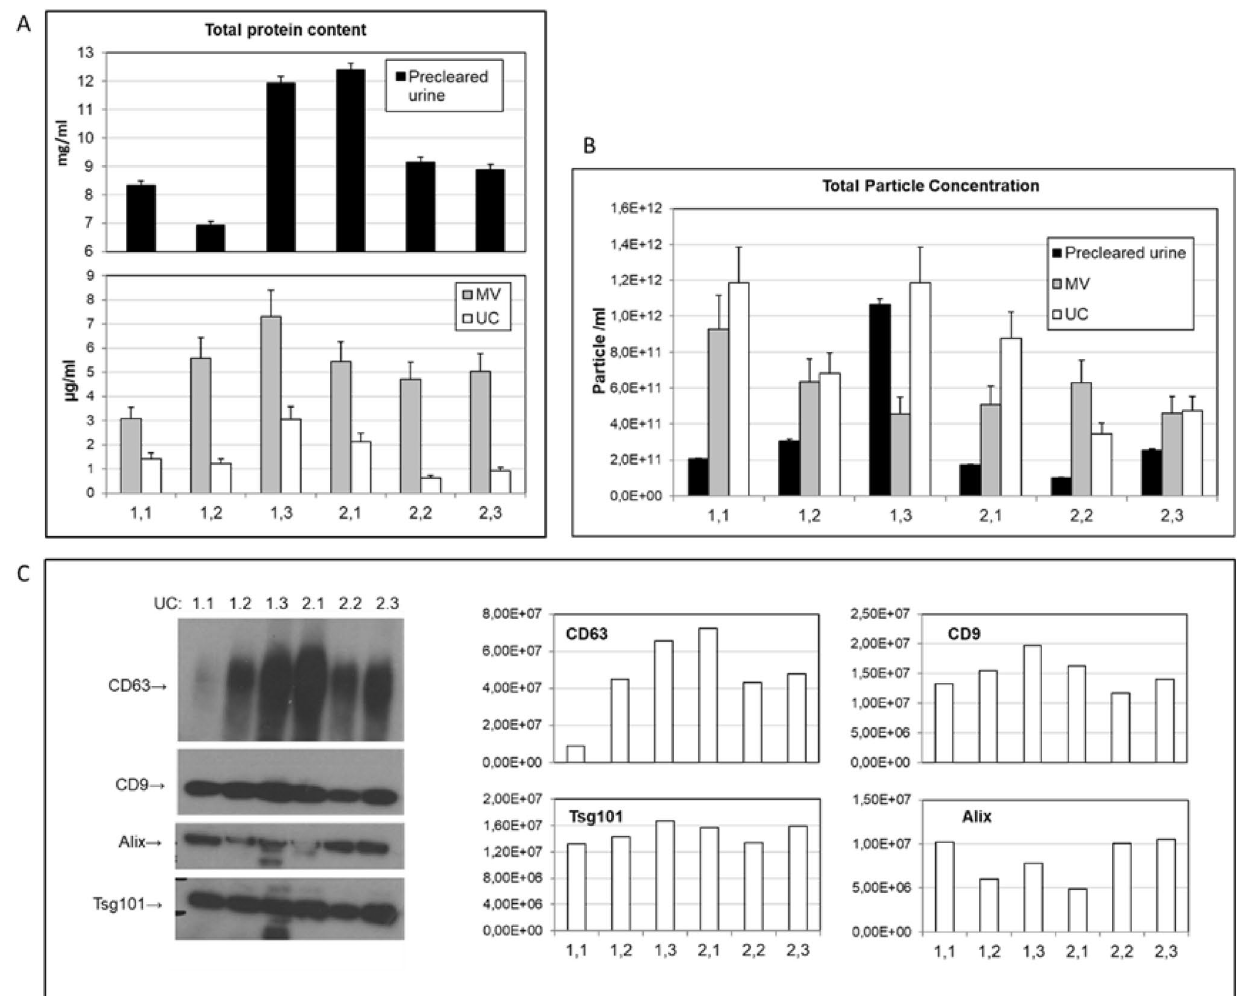
Figure 5. Comparative analysis of EVs content in longitudinal urine samples. EVs (UC) and MVs were purified by differential (ultra)centrifugation-based protocol from urine obtained from two healthy volunteers, one female (marked as 1) and one male (marked as 2), 45 and 43 years old, in 3 subsequent days. For each sample two aliquots of urine were processed independently and results presented as averages + SD. Total protein content was measured in a whole urine, MVs and EVs by BCA assay ( A ) particle concentration determined by NTA measurement ( B ) and EV proteins assessed by Western Blot ( C ). The signal intensity on the blot was further analyzed and quantified by densitometric analysis using ImageJ software and plotted on the